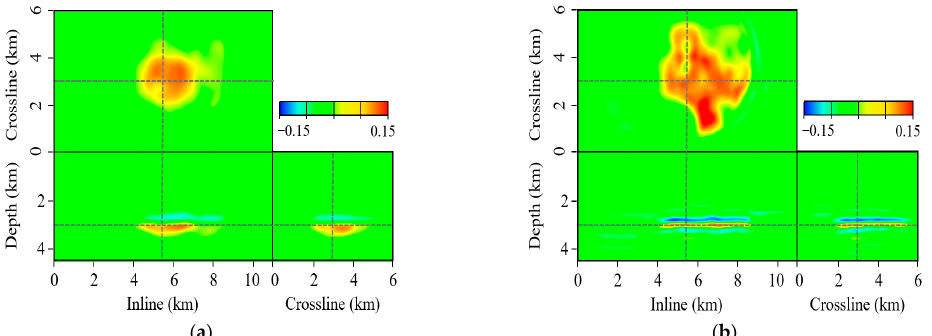
Figure 9. Monitoring results by subtracting two RTM images from the baseline and post-injection survey with ( a ) mode I (conventional) and ( b ) mode V (small angle) of DAF. The inverted velocity model (Figure 6b) using FWI with mode IV of DAF is used.